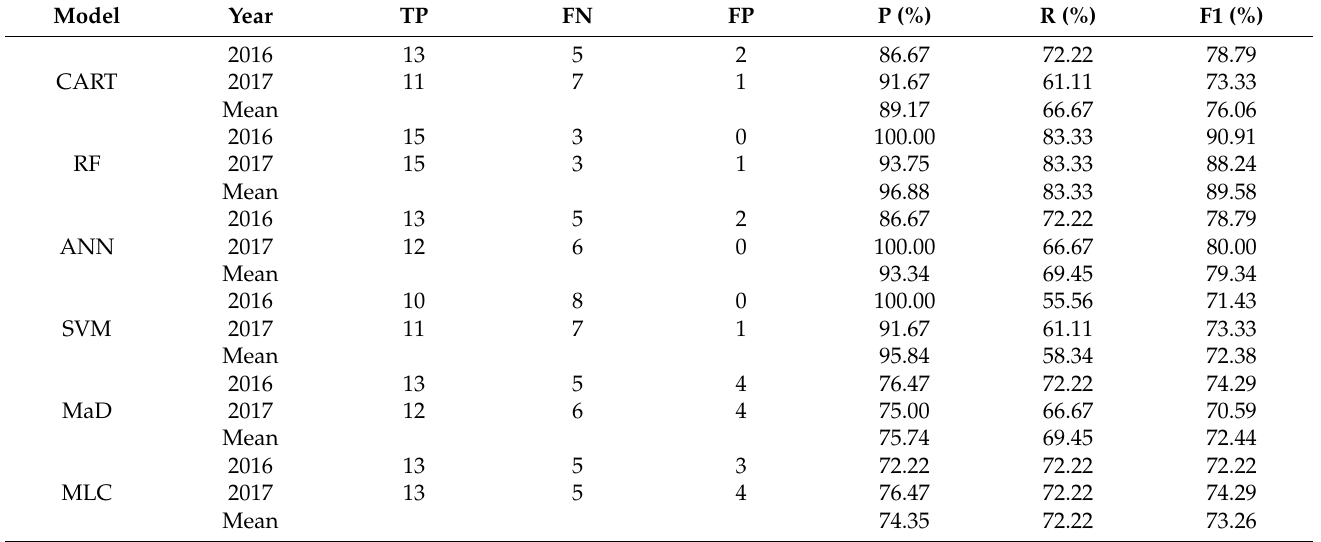
Table 2. Accuracy evaluation in region